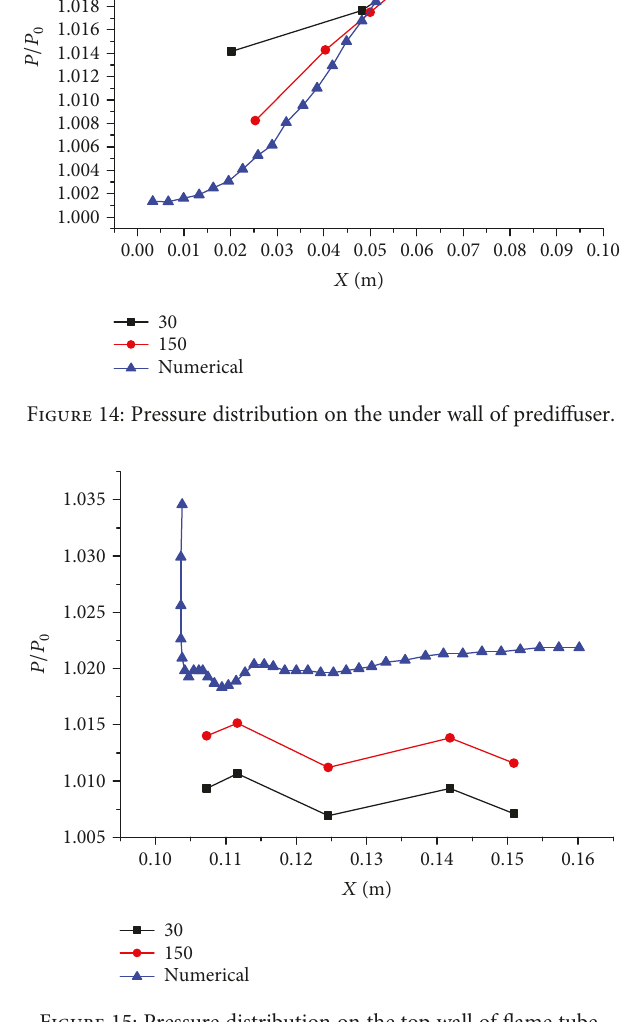
Figure 15: Pressure distribution on the top wall of fl ame